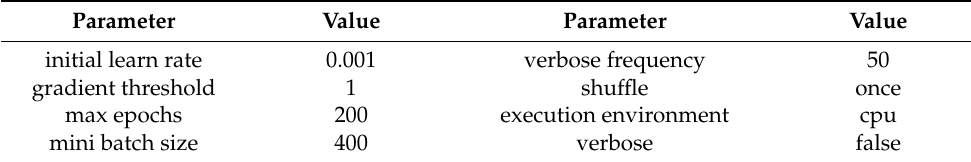
Table 7. Training options Adam of the CNN for simple supported steel beam database.